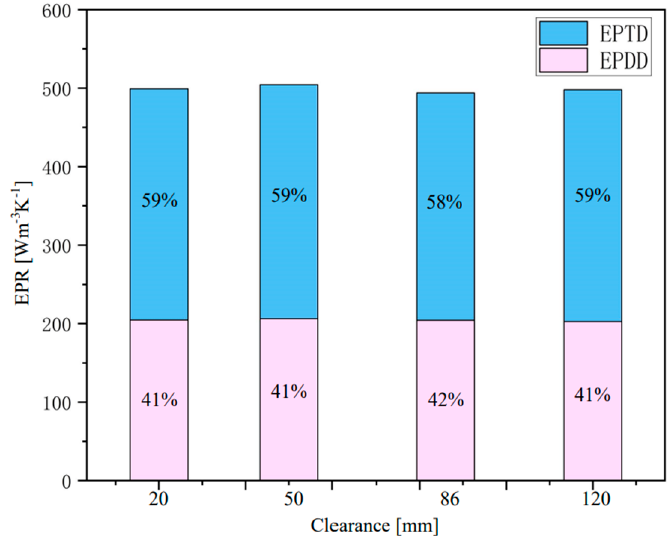
Figure 12. Distribution of EPR under different clearance configurations.